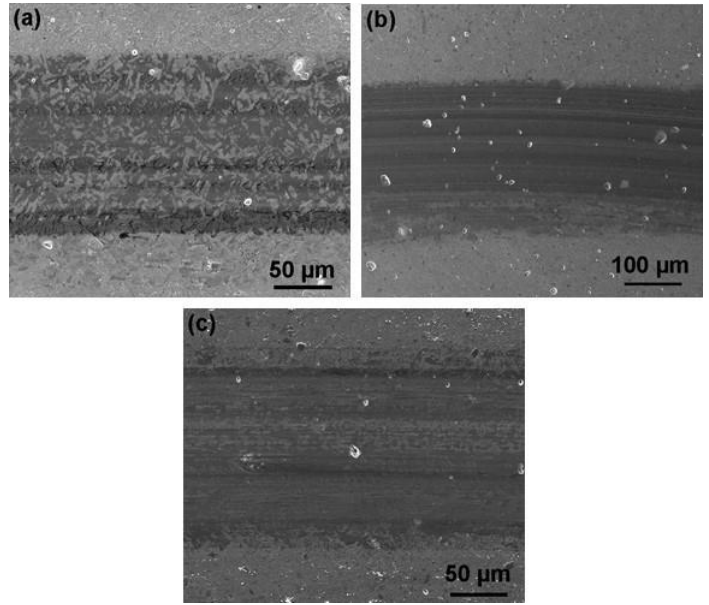
Figure 12. Wear tracks generated on TiAlN/VN coating when sliding against alumina ball in vacuum ( a ) ambient temperature ( b ) 350 °C ( c ) 550 °C.